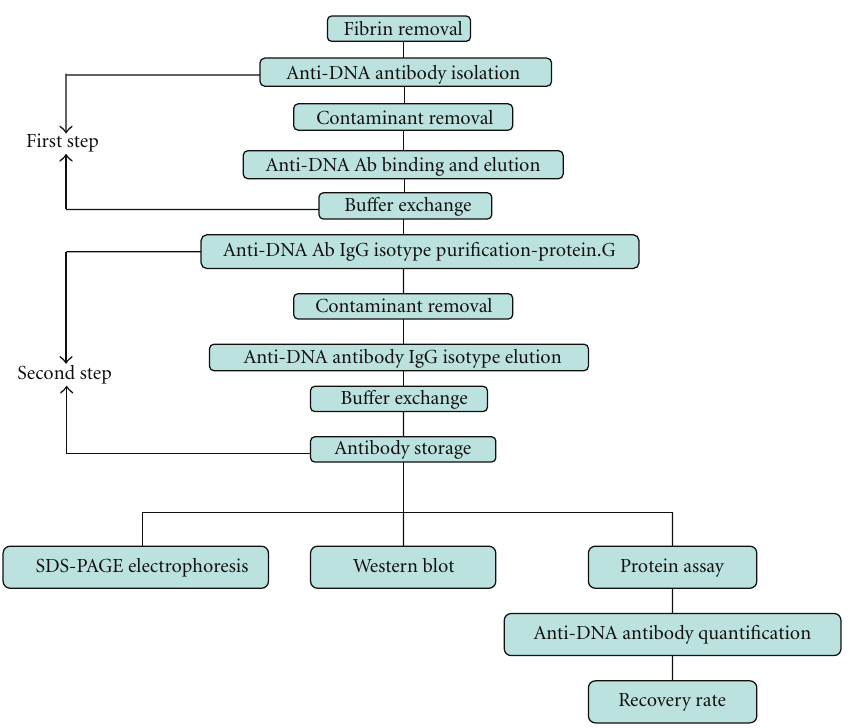
Figure 4: Scheme of two step magnetic bead based purification of IgG from serum of patients with